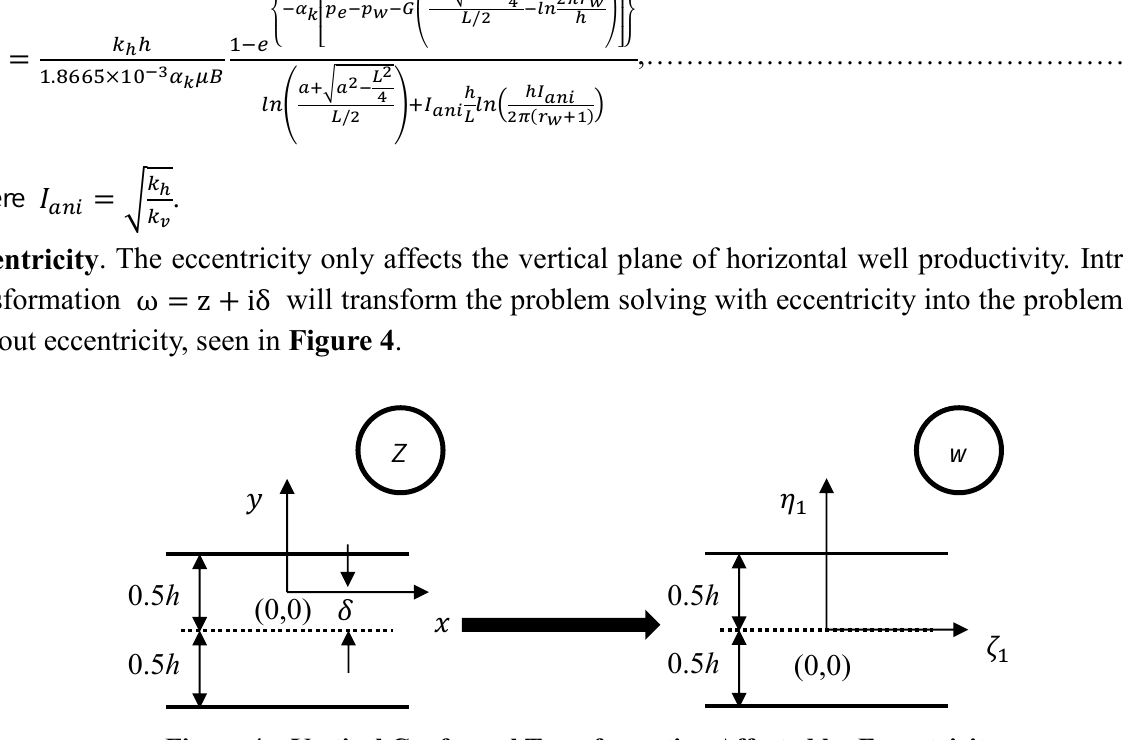
Figure 4—Vertical Conformal Transformation Affected by